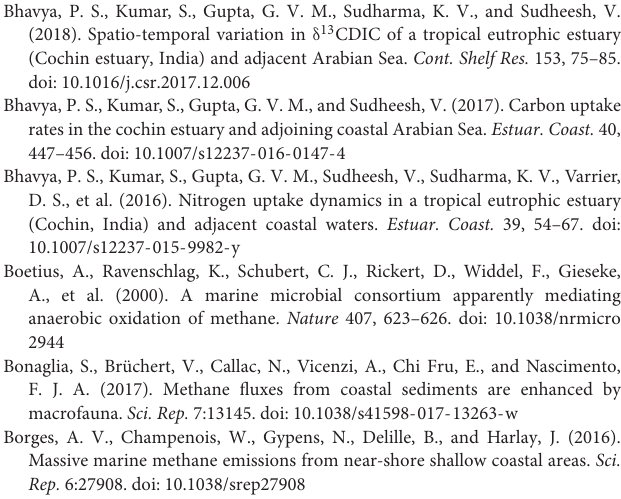
FIGURE S1 | Surface CH 4 concentrations in the Cochin estuary during